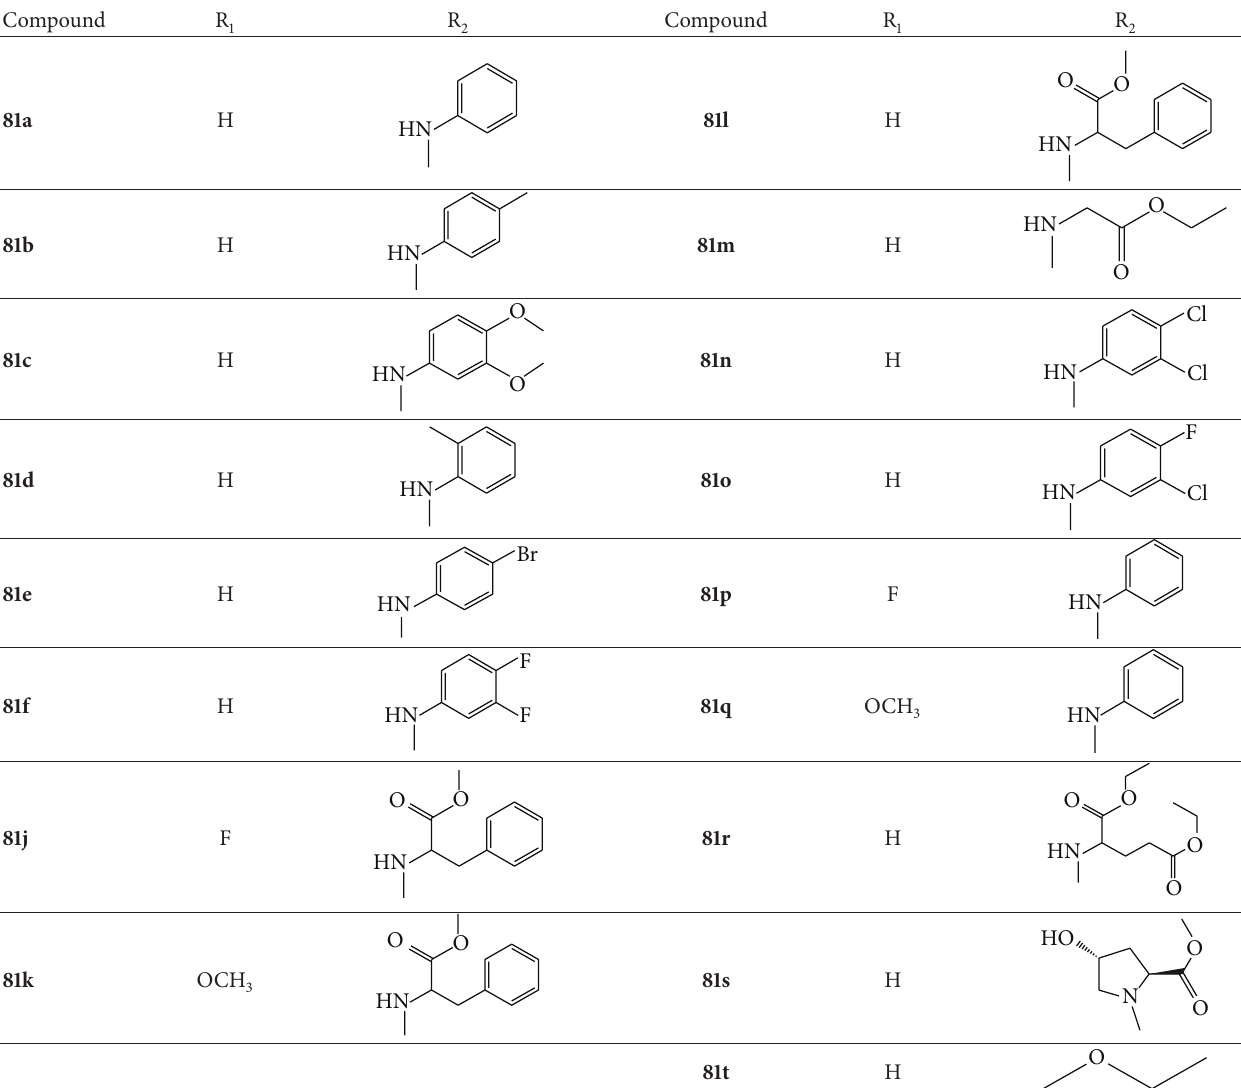
Table 12: List of compounds